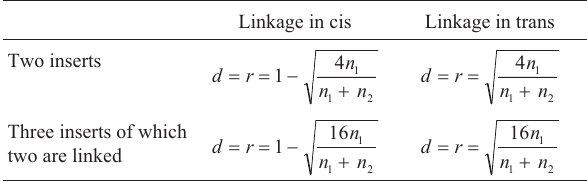
quency of resistant